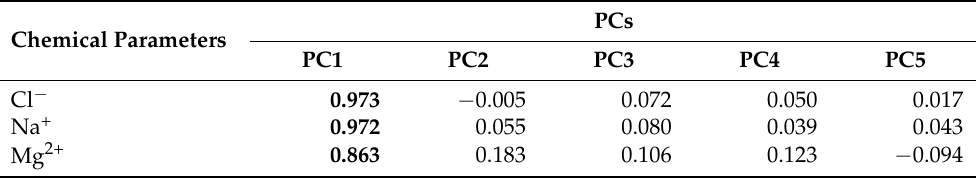
Table 2. Principal component (PC) loadings for groundwater chemical parameters in the coastal alluvial aquifer of the Pearl River Delta.